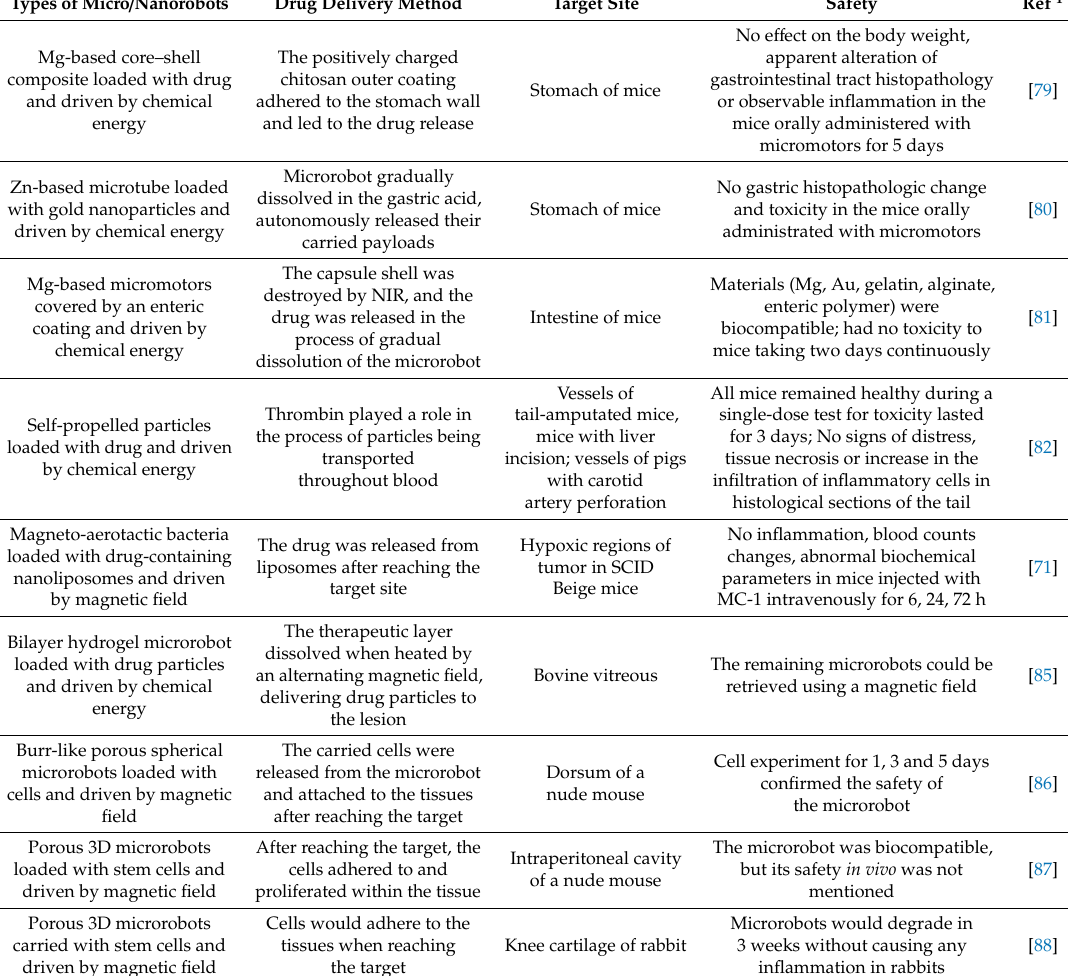
Table 2. Application of drug-loaded micro / nanorobots in animal models in recent